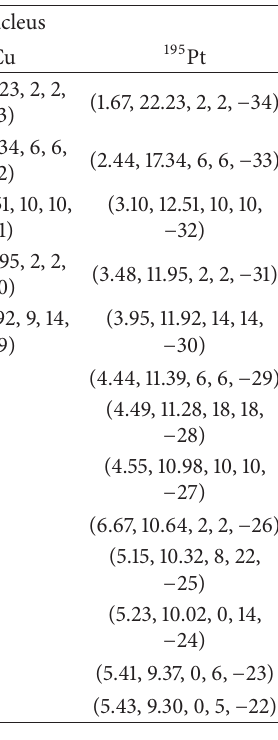
Table 1: Brackets contain ⟨𝑟 2 ⟩ 1/2 (Fermi), ℎ𝜔 (MeV), 𝑔 𝑝 𝑛𝑙 , 𝑔 𝑛 𝑛𝑙 , and 𝜀 𝑛𝑙 (MeV) parameters used in calculating the structure function of 63 Cu and 195 Pt nuclei for shells with quantum number n , l , respectively. ⟨𝑟 2 ⟩ 1/2 is taken from [30] for each